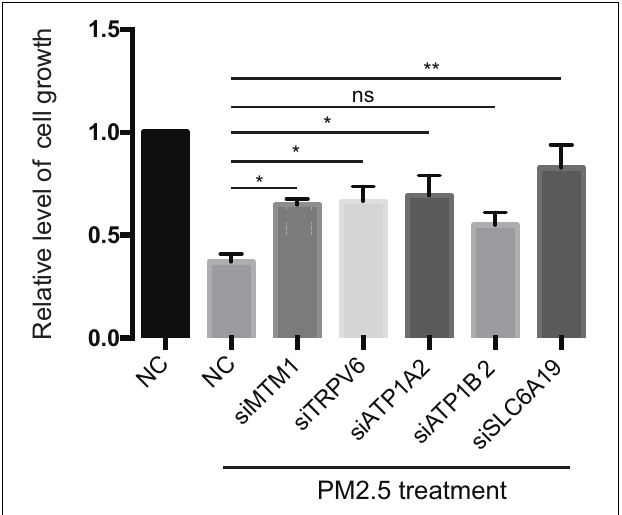
FIGURE 3 | Knockdown of mineral absorption-related genes rescued the reduction of cell viability by PM 2 . 5 . L02 cells were transfected with siRNAs targeting each candidate gene, then cells exposed to PM 2 . 5 . Cell viability was analyzed by MTT. * p < 0.05, ** p < 0.01. ns, no significance. Data are representative of three independent experiments with n = 3 (Mean ± SEM), normalized by NC